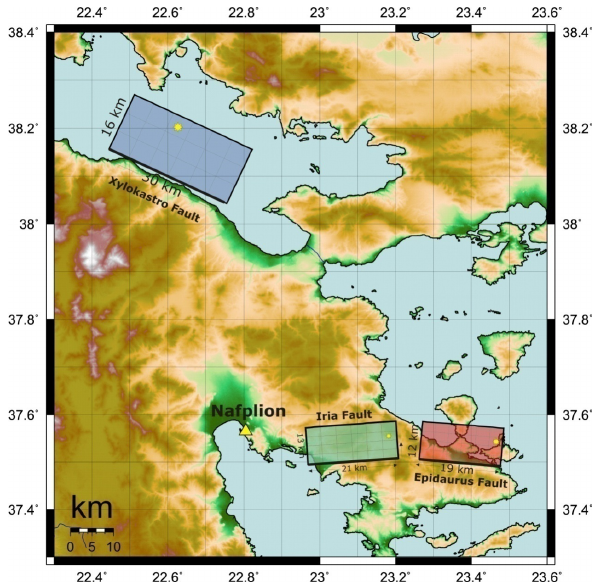
Fig. 9. Seismic source models adopted in the stochastic strong ground motion simulation method for the three examined earth- quake scenarios. Model fault surfaces are devided into subfaults. Yellow asterisks denote the locations of the assumed rupture initia- tion points (assumed to coincide with the